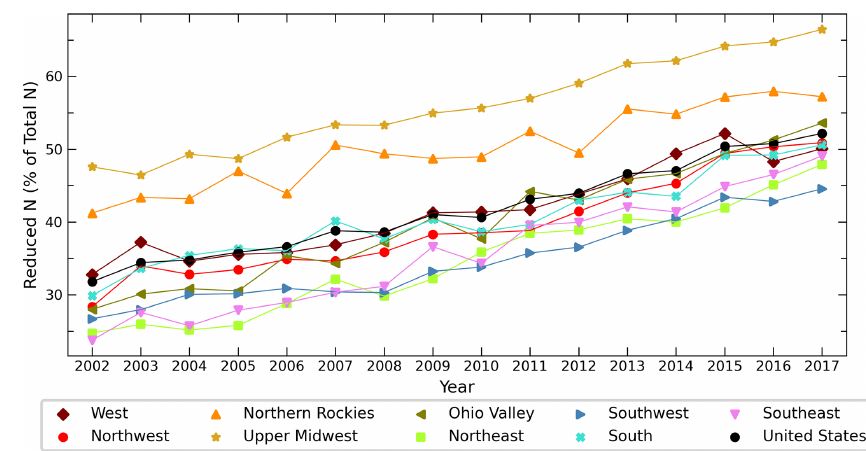
Figure 10. Changes in the percent of total N deposited as reduced nitrogen from 2002 to 2017 throughout the NOAA climate regions and